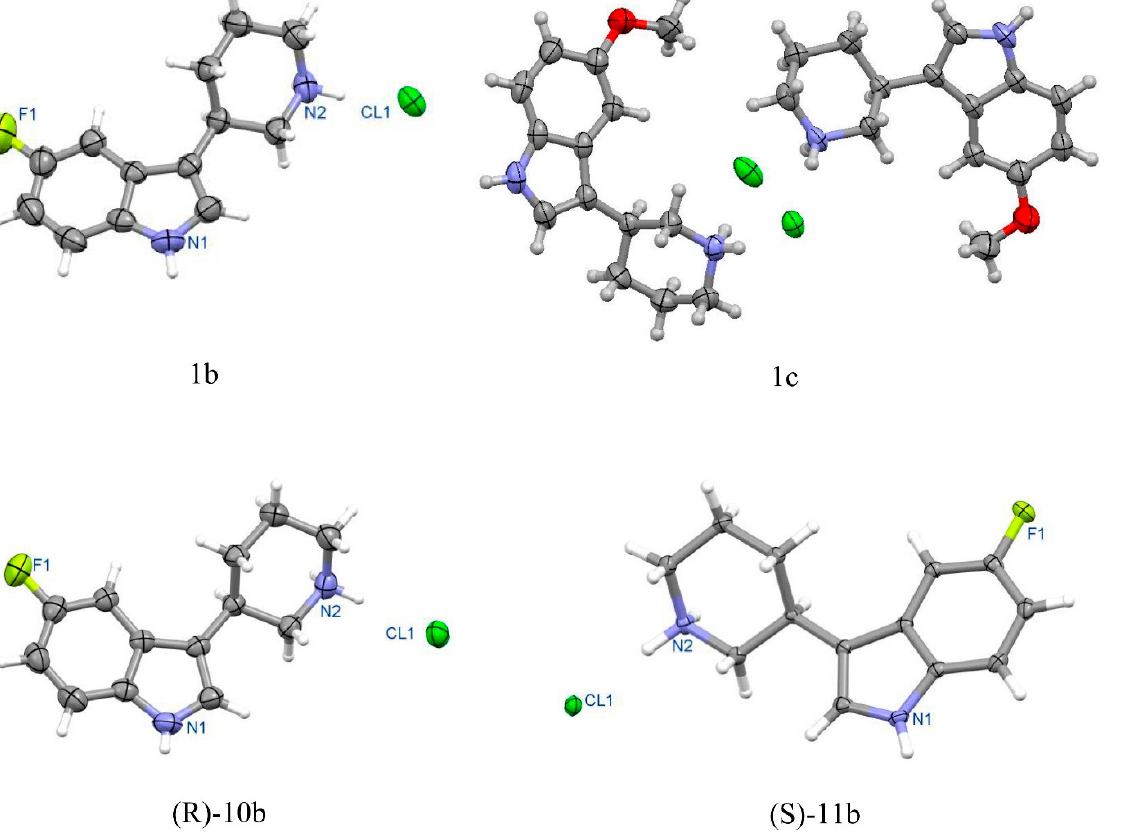
Figure 4. Perspective view of molecule 1b and 1c in racemic crystal [17,18] and view of molecular structure of enantiomeric fluoro-derivatives.